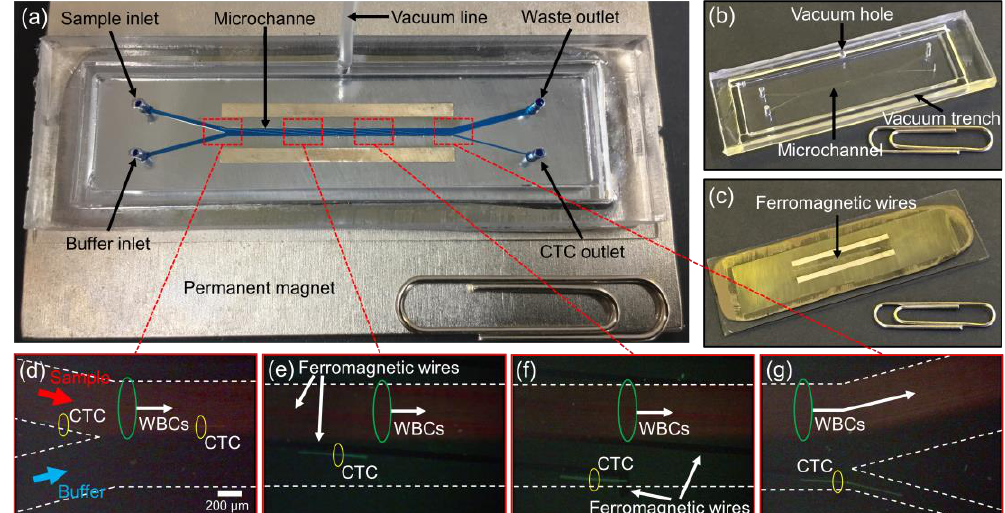
Figure 2. Photographs of ( a ) the CTC-µChip, consisting of ( b ) the disposable microchannel superstrate and ( c ) the reusable substrate, assembled via vacuum pressure. Enlarged views of ( d ) the sample and buffer inlets, ( e ) the early and ( f ) late points of the microchannel, and ( g ) the waste and CTC outlets.